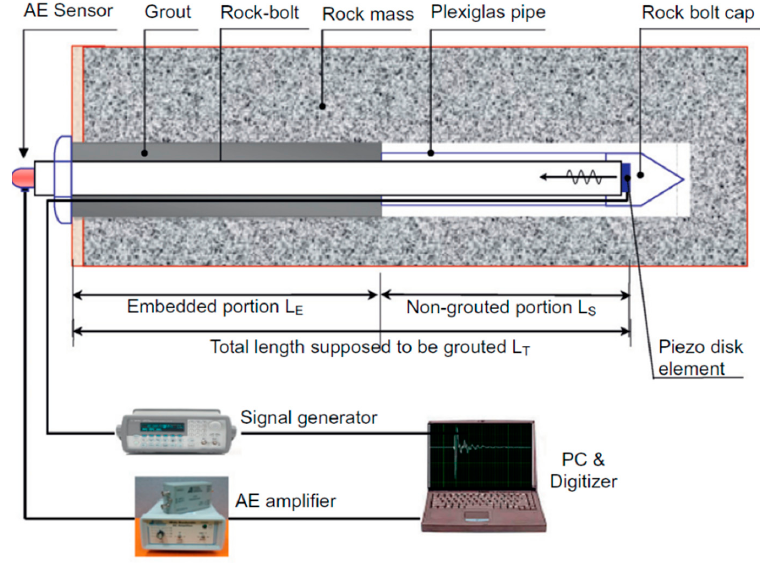
Figure 20. Schematic diagram of the rock bolt integrity system [66].